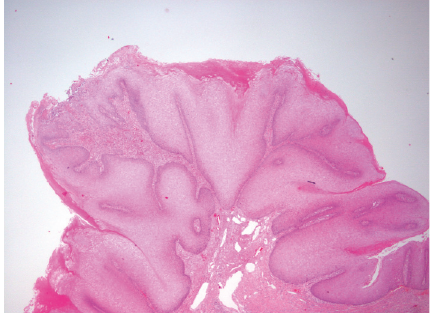
Figure 2: A satisfactory cosmetic result was recorded at 3 months (left) and 6 months (right) postoperatively.